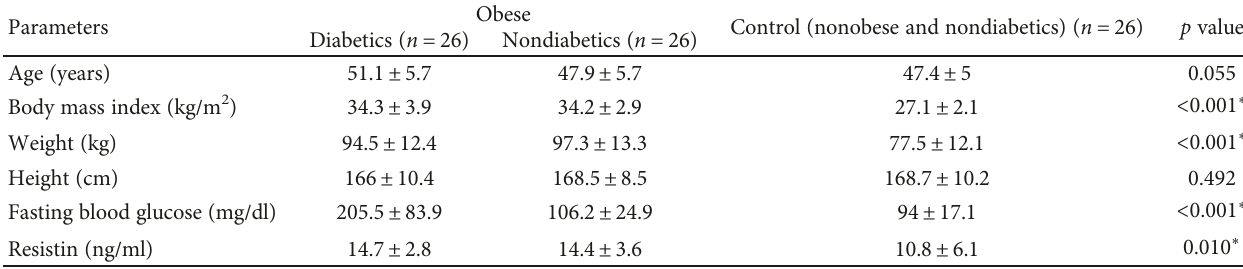
Table 2: General information of the study population and laboratory results. The fi gures shown are mean ± standard deviation. Obese Parameters